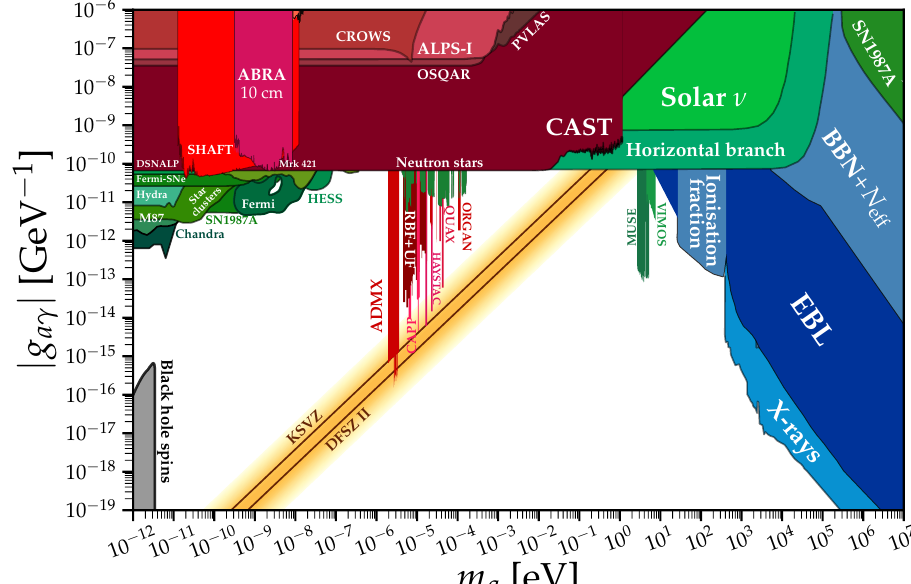
Figure 1. Axion parameter space showing the exclusion limits of experiments. The yellow band is representative of the QCD axions, together with the brown lines showing theoretical predictions of the KSVZ [9,10] and DFSZ [11,12] models. The plot is freely available from the online repository of